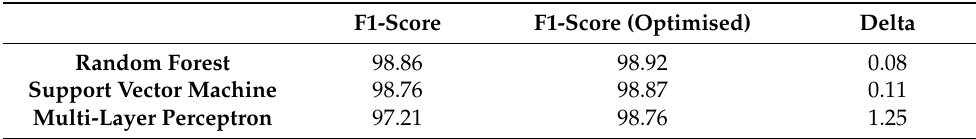
Table 5. Comparison of optimised models.